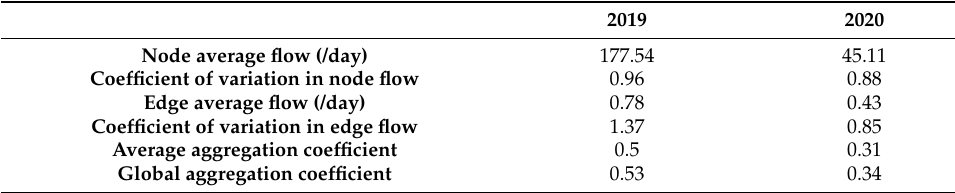
Table 2. Statistical values of network indicators in two time periods of 2019 and 2020.